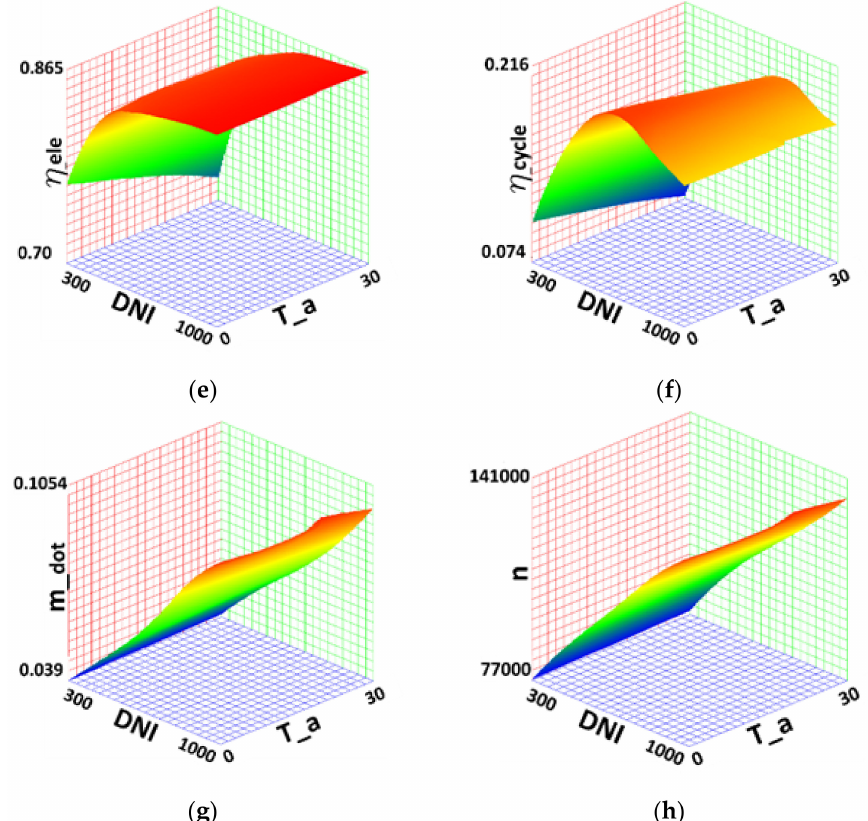
Figure 16. System performance for any given combination of DNI and Ta (cavity receiver option, receiver window diameter: 22 cm). ( a ) TIT ( ◦ C); ( b ) Compressor Pratio; ( c ) Mechanical power